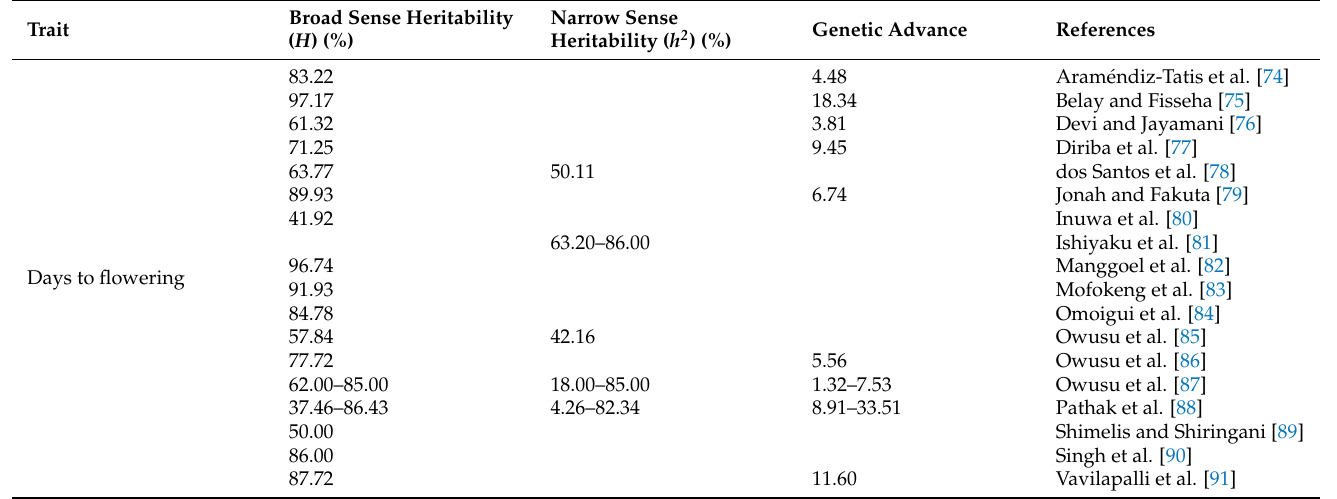
Table 1. Heritability in the broad and narrow sense, and genetic advance of cowpea ( Vigna unguiculata cv-gr unguiculata)